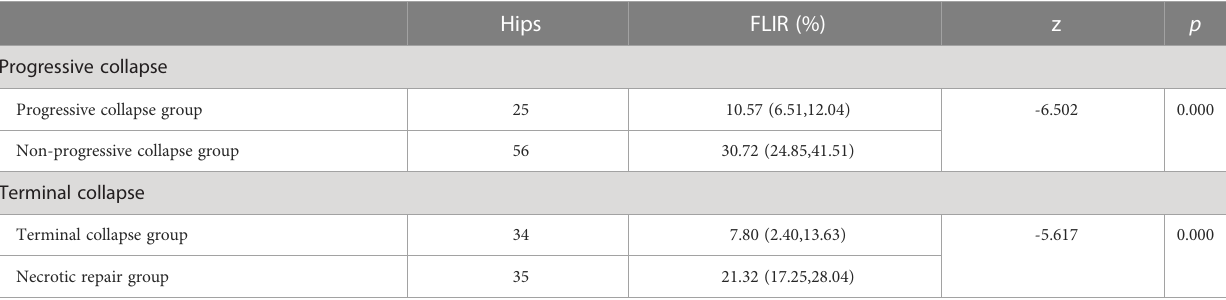
TABLE 3 The correlation between FLIR and collapse.